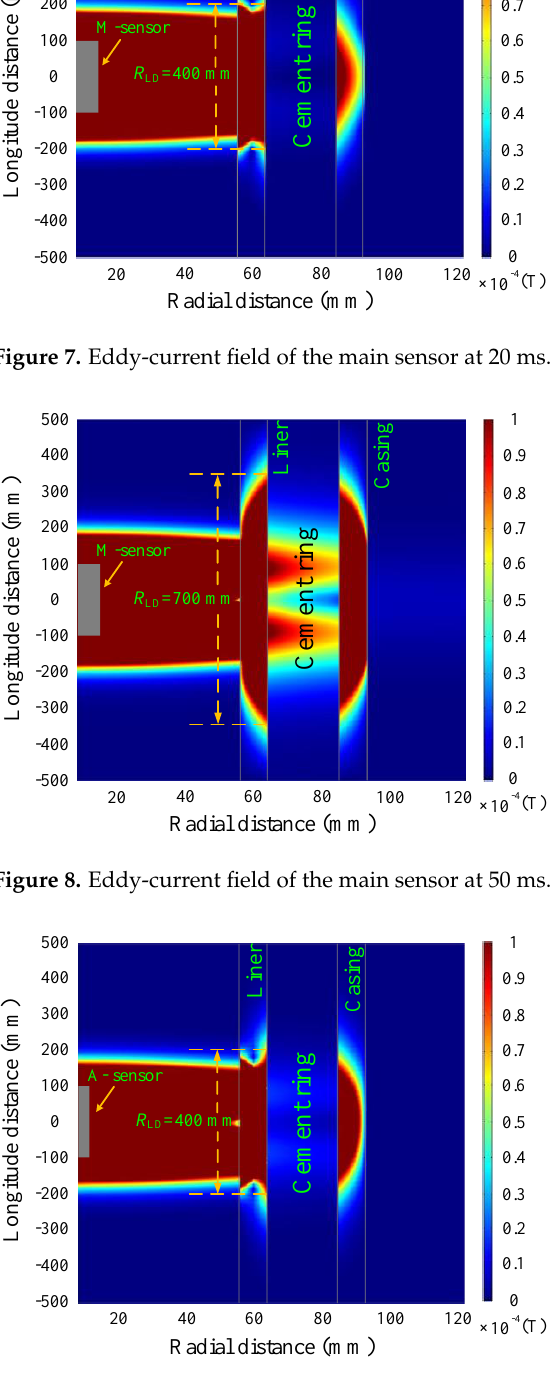
Figure 9. Eddy-current field of the auxiliary sensor at 30 ms. A comparison of Figures 7 and 9 reveals that the auxiliary sensor at 30 ms has almost the same longitudinal diffusion range as the main sensor at 20 ms, whereas their radial diffusion properties differ. On the one hand, because of their different radial properties, the two metal pipes differently influence the response of the magnetic field; thus, the principle behind the NDI of multipipe strings, discussed in Section 3, can be used to solve Equation (12) with two unknown thicknesses. On the